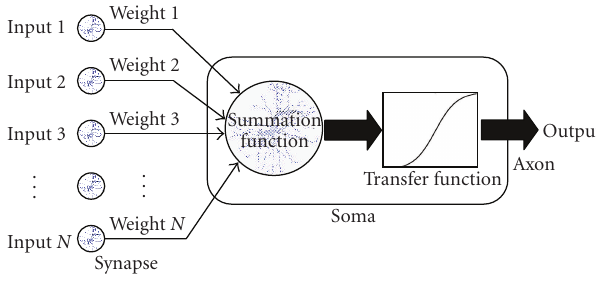
Figure 2: The artificial representation of the biological